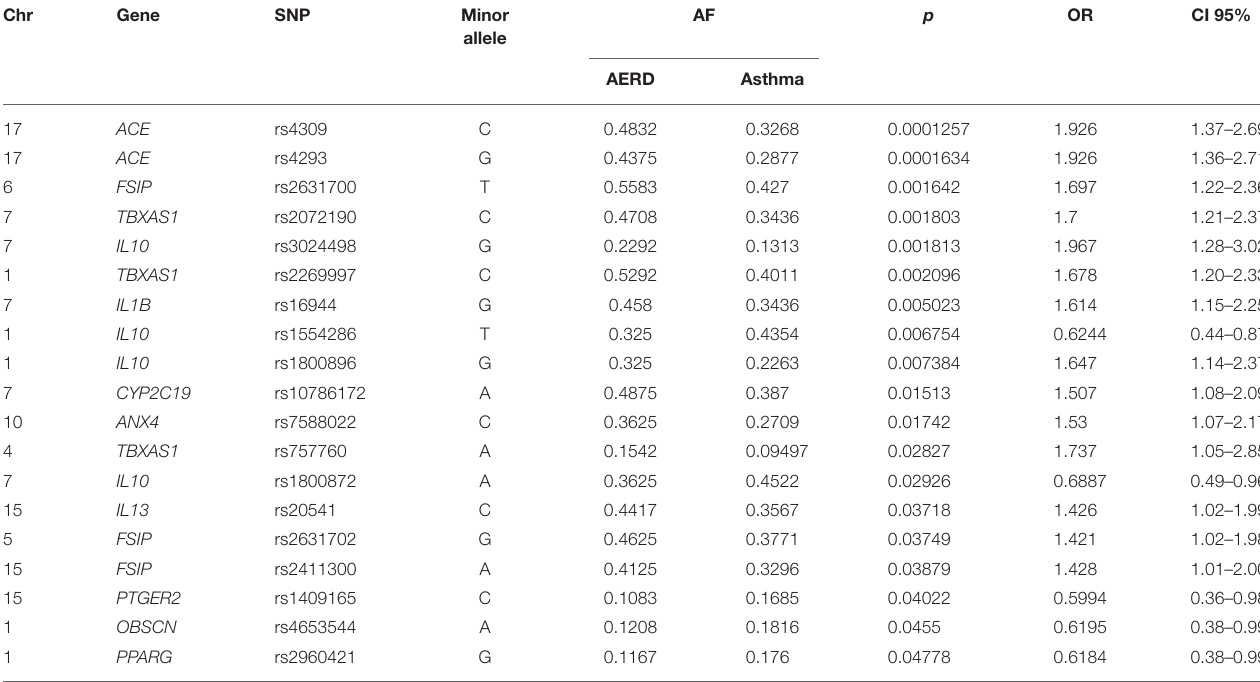
TABLE 3 | Allele frequency comparison between AERD vs. Asthma group.